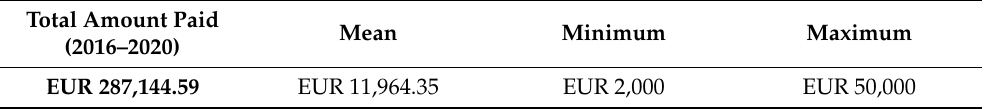
Table 1. Compensation paid in the period of